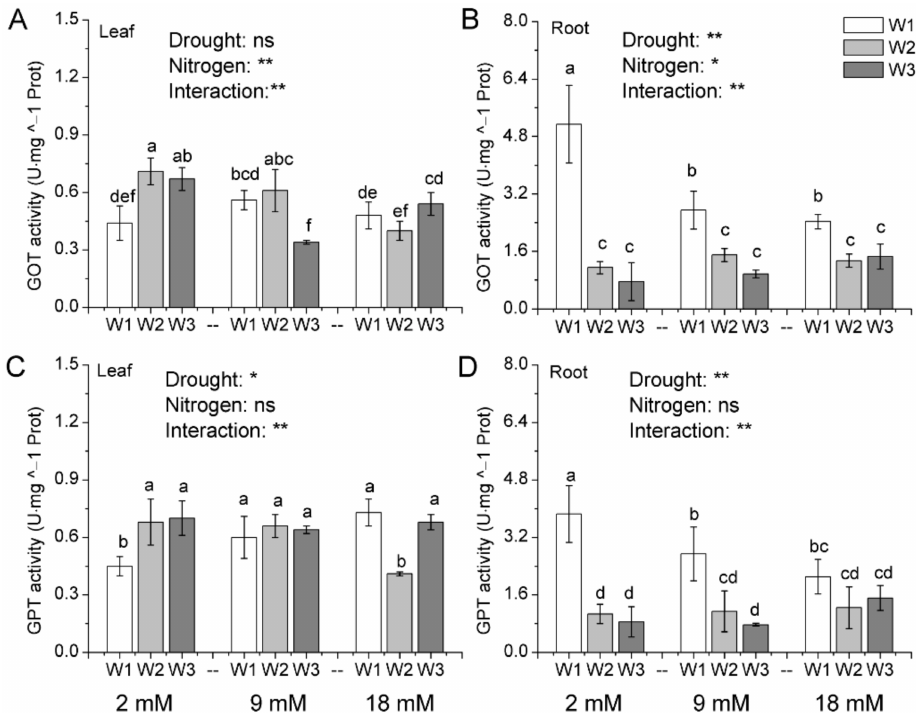
Figure 6. The activity of glutamic oxalacetic transaminase ( A , B ) and glutamic pyruvic transaminase ( C , D ) in leaves and roots of pakchoi as affected by drought and nitrogen supply. W1: 0 g · L − 1 PEG 6000, blank; W2: 60 g · L − 1 PEG 6000, mild drought stress; W3: 120 g · L − 1 PEG 6000, moderate drought. Bars with the different letters indicate significant difference ( p < 0.05). Error bars represent the standard deviation. p -values of the ANOVAs of drought, nitrogen supply, and their interaction are indicated. ns, not significant. * p < 0.05. ** p <